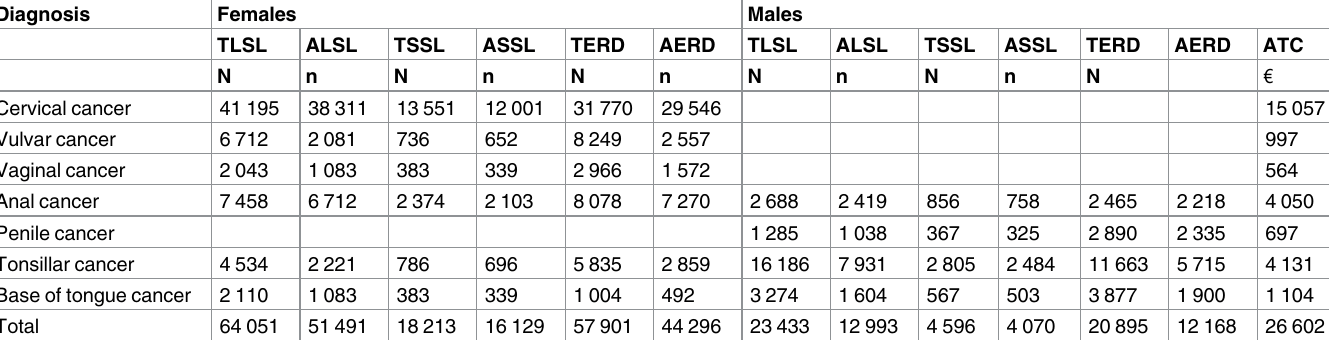
Table 3. Number of registered sick leave and early retirementdays and HPV-attributable sick leave and early retirement days in 2006, presented in €